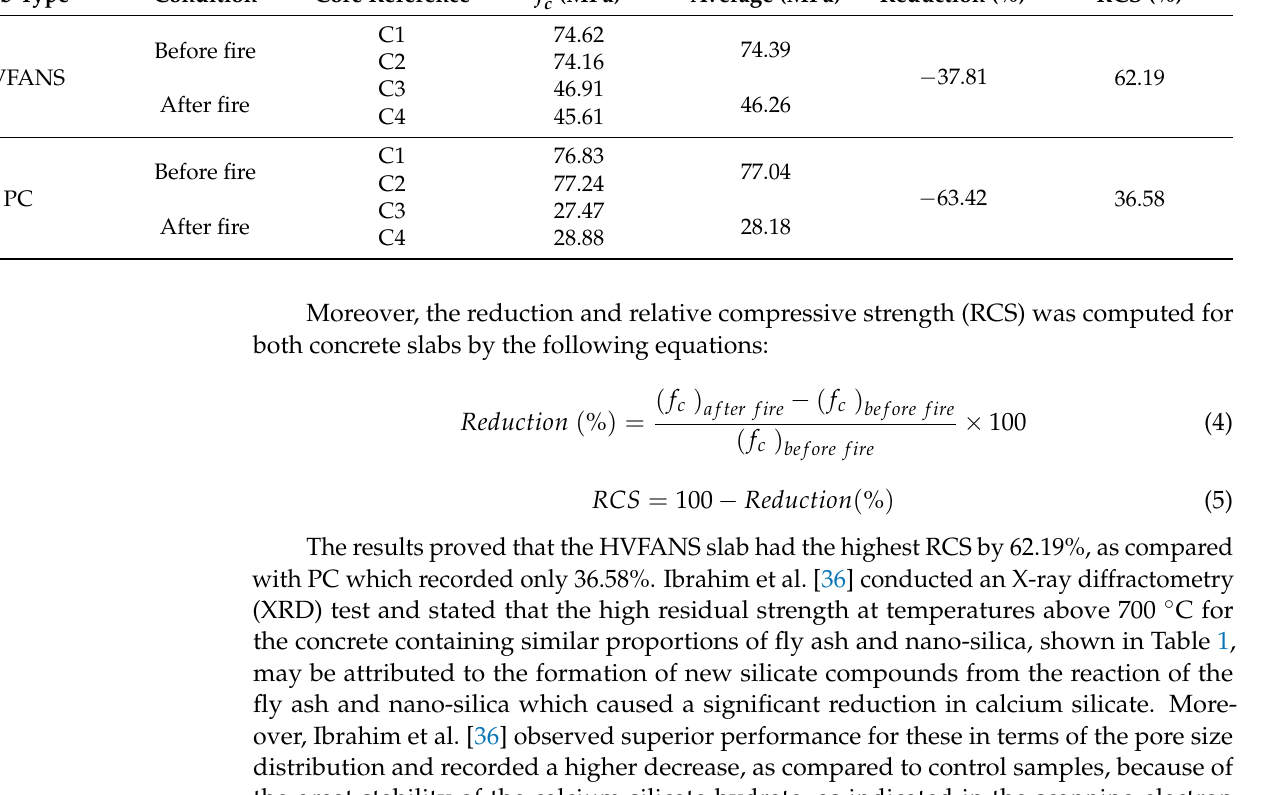
Table 4. Compressive strength ( f c ) of PC and HVFANS slabs before and after firing. Slab